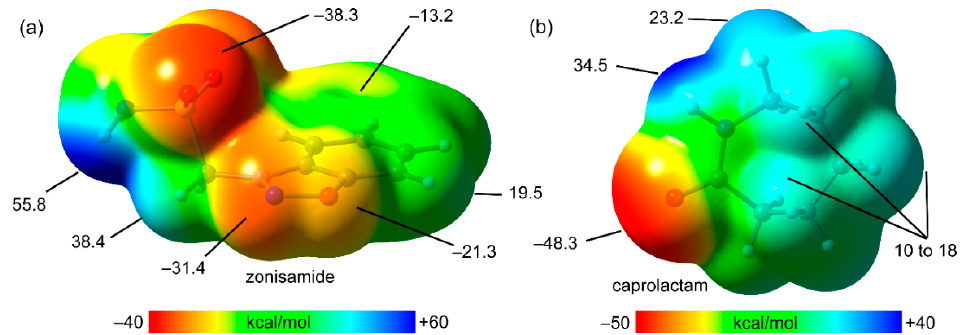
Figure 9. MEP surfaces of zonisamide ( a ) and ϵ -caprolactam ( b ) at the PBE0-D3/def2-TZVP level of theory (density isovalue 0.001 a.u.). The energies are given in kcal/mol.